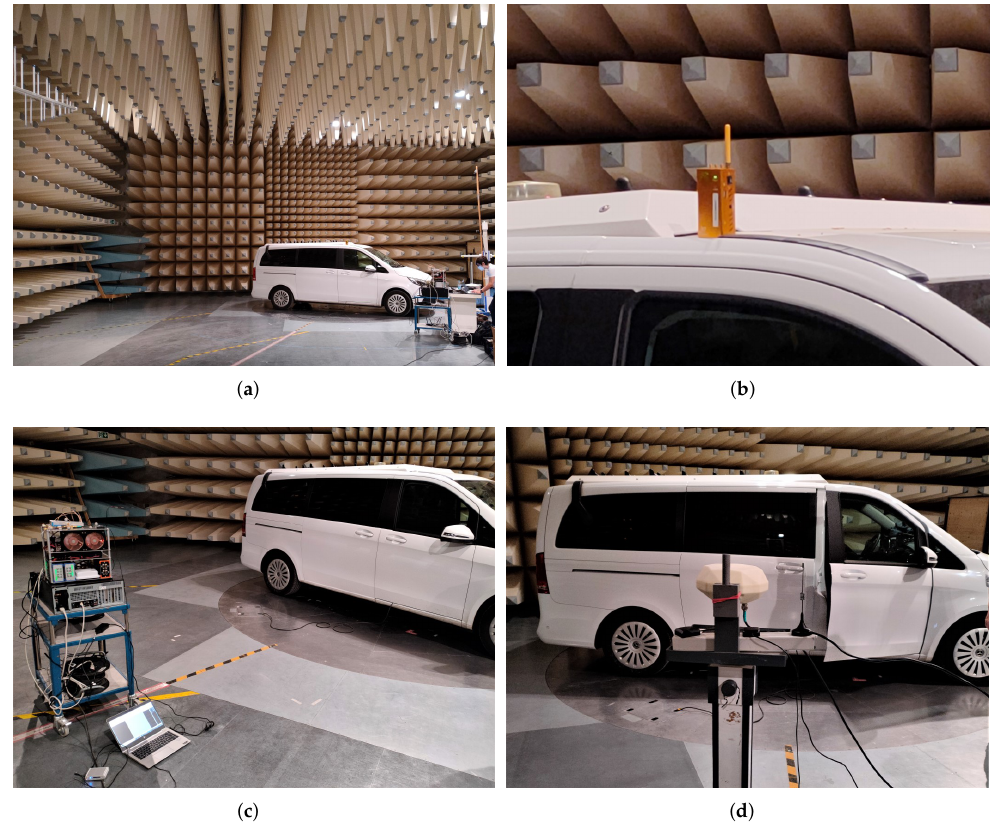
Figure 15. Test setup inside a large anechoic chamber, which is sufficiently big to fit a testing vehicle. Additionally, the vehicle is on a platform that can be rotated so that the signal path through different angles is measurable. ( a ) Inside the large anechoic chamber. ( b ) A PPD evaluated. ( c ) The monitoring system and other receivers (on the left). ( d ) Antenna mounting with different beam patterns.